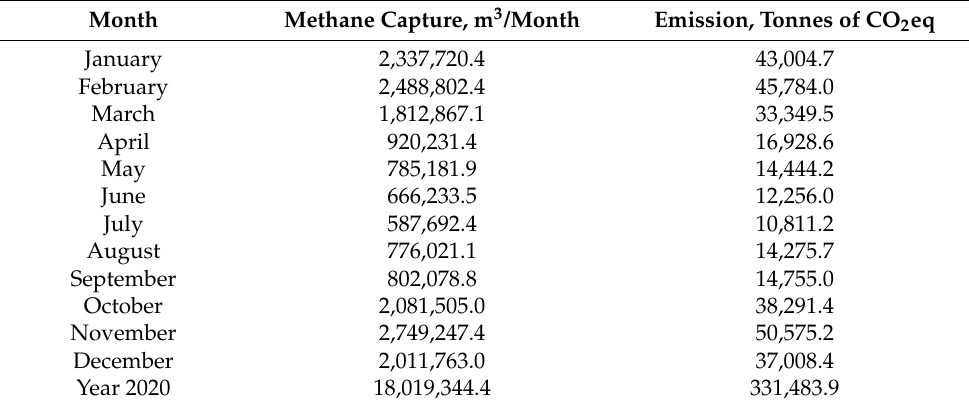
Table 4. Monthly summary of methane capture and emission expressed in CO 2 equivalent.